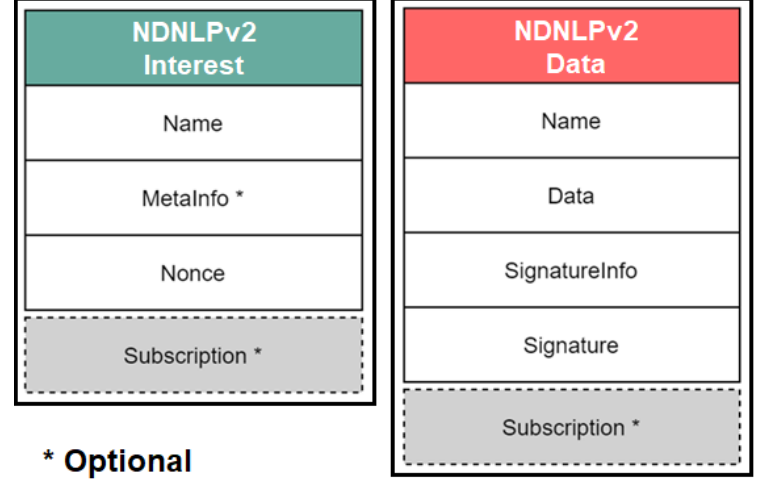
Figure 3. ndnIoT-FC pub-sub packet